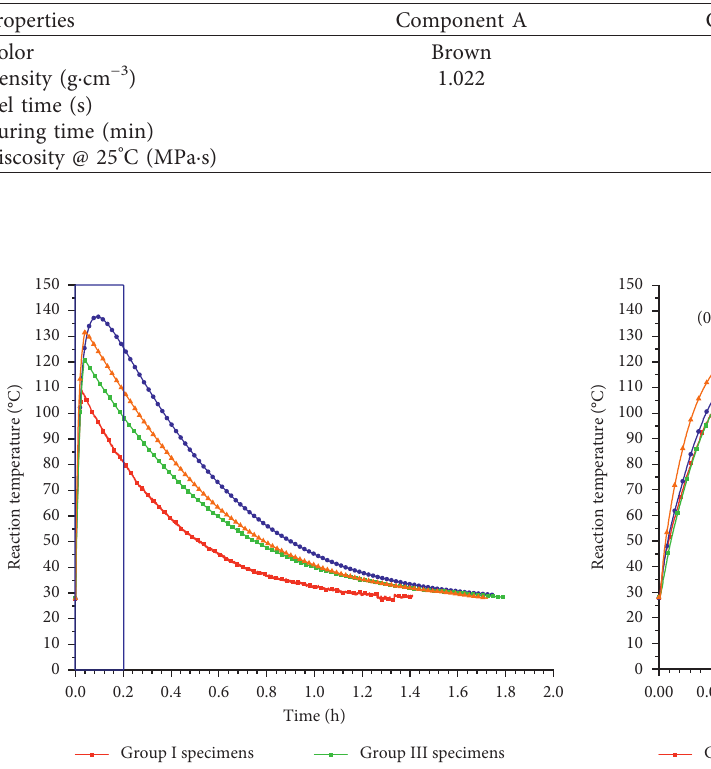
Table 4: Physical and chemical properties of component A, component B, and their mixture.